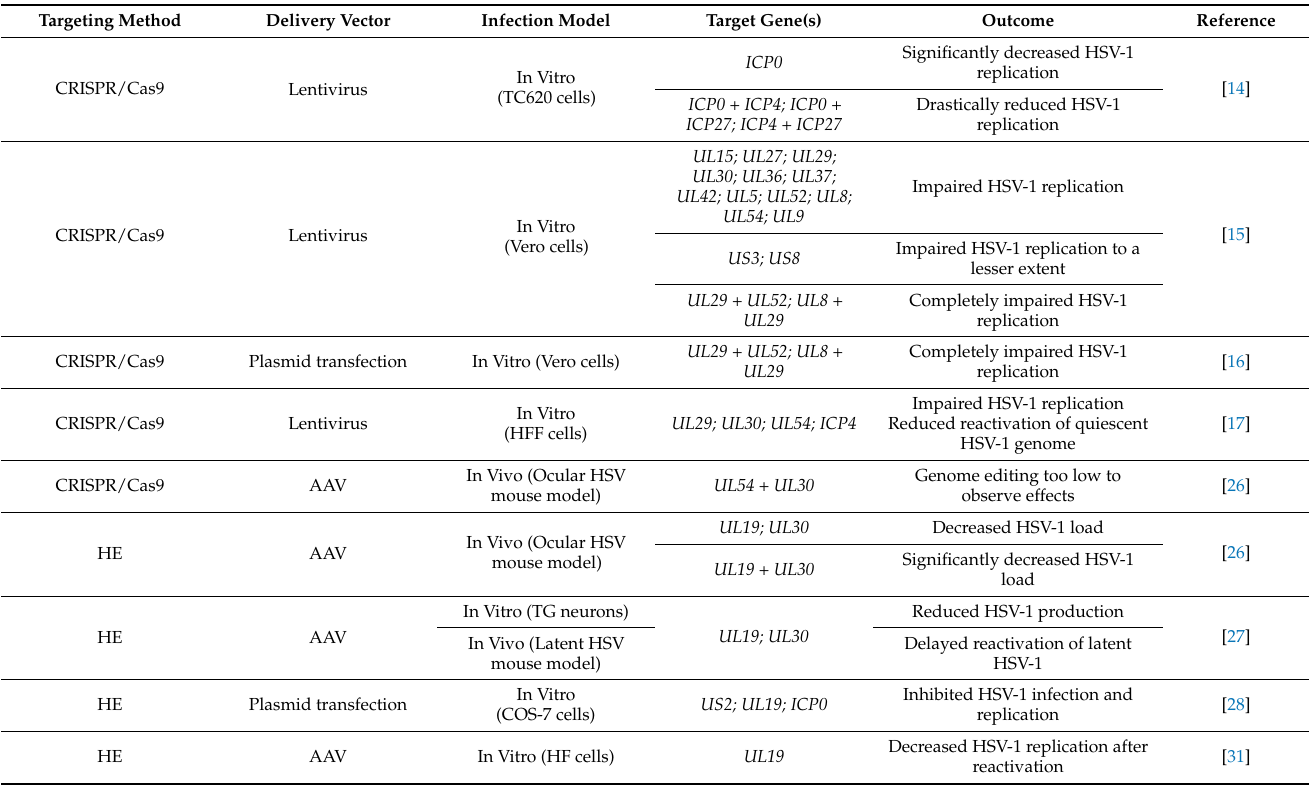
Table 1. List of HSV-1 genes targeted by CRISPR/Cas9 or HE strategies and their impact on HSV-1 replication and